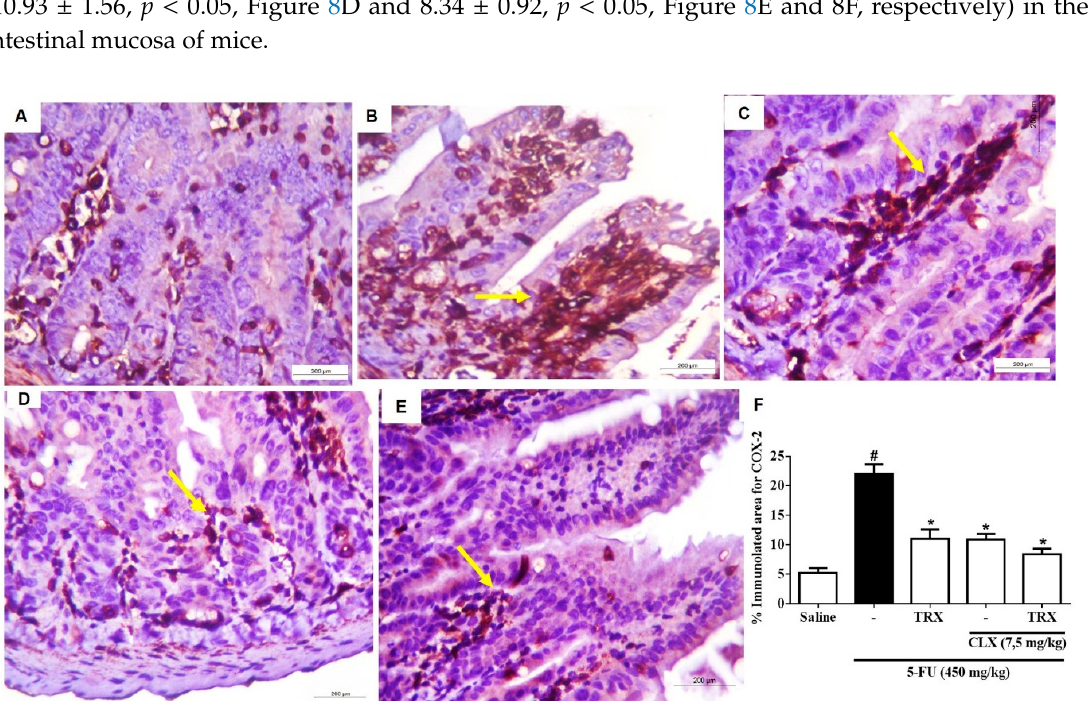
Figure 8. Immunohistochemistry analysis for COX-2 expression evaluation. Saline ( A ); 5-FU ( B ); TRX-100 ( C ); CLX ( D ); TRX and CLX ( E ); % immunolabelled for COX-2 ( F ). Values were expressed as mean ± SEM. For statistical analysis, one-way ANOVA followed by Tukey’s test was used, where # p < 0.05 vs. saline group, * p < 0.05 vs. group